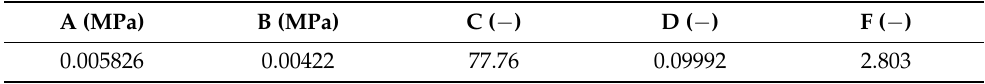
Table 2. Parameter list obtained for the G’Sell hardening